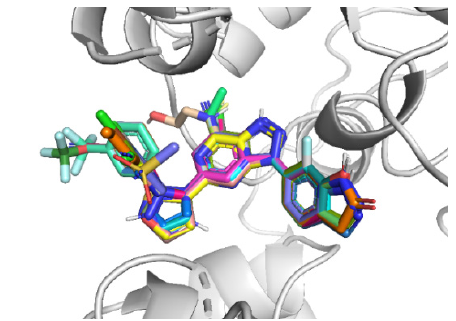
Figure 3. Alignment of the dataset compounds inside the active site of CD73.